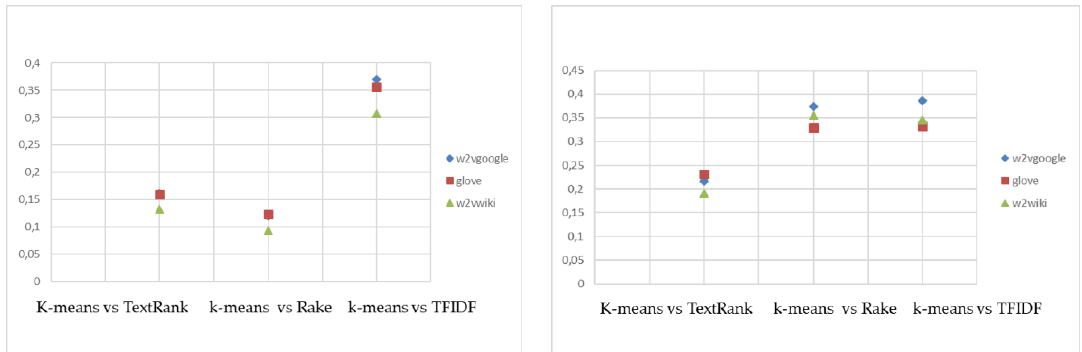
Figure 6. Comparison of results of this method (using k-means clustering and Cosine similarity) with baseline on 1-g (on the left) and n -grams (on the right).